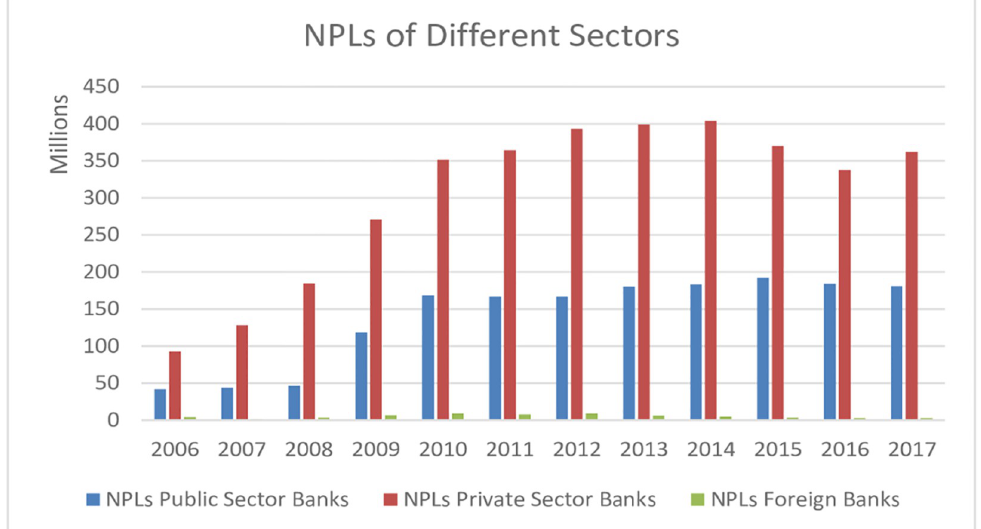
Fig 2. Growth of NPLs in different sectors of Pakistan’s CBs industry for the period